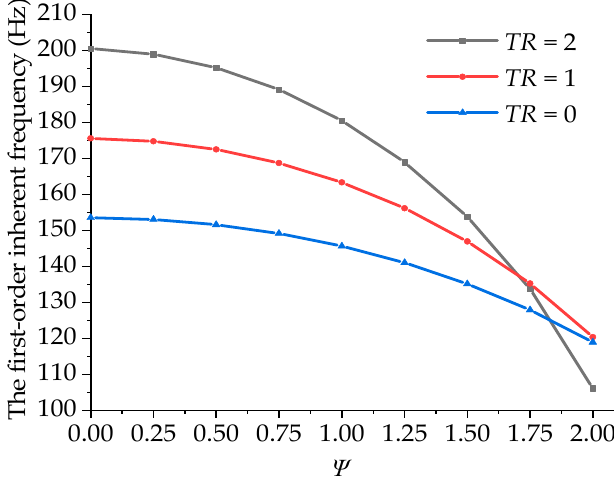
Figure 5. Variations in the first-order inherent frequency with the material damping of the boring bar under different taper ratios ( L/d = 10).